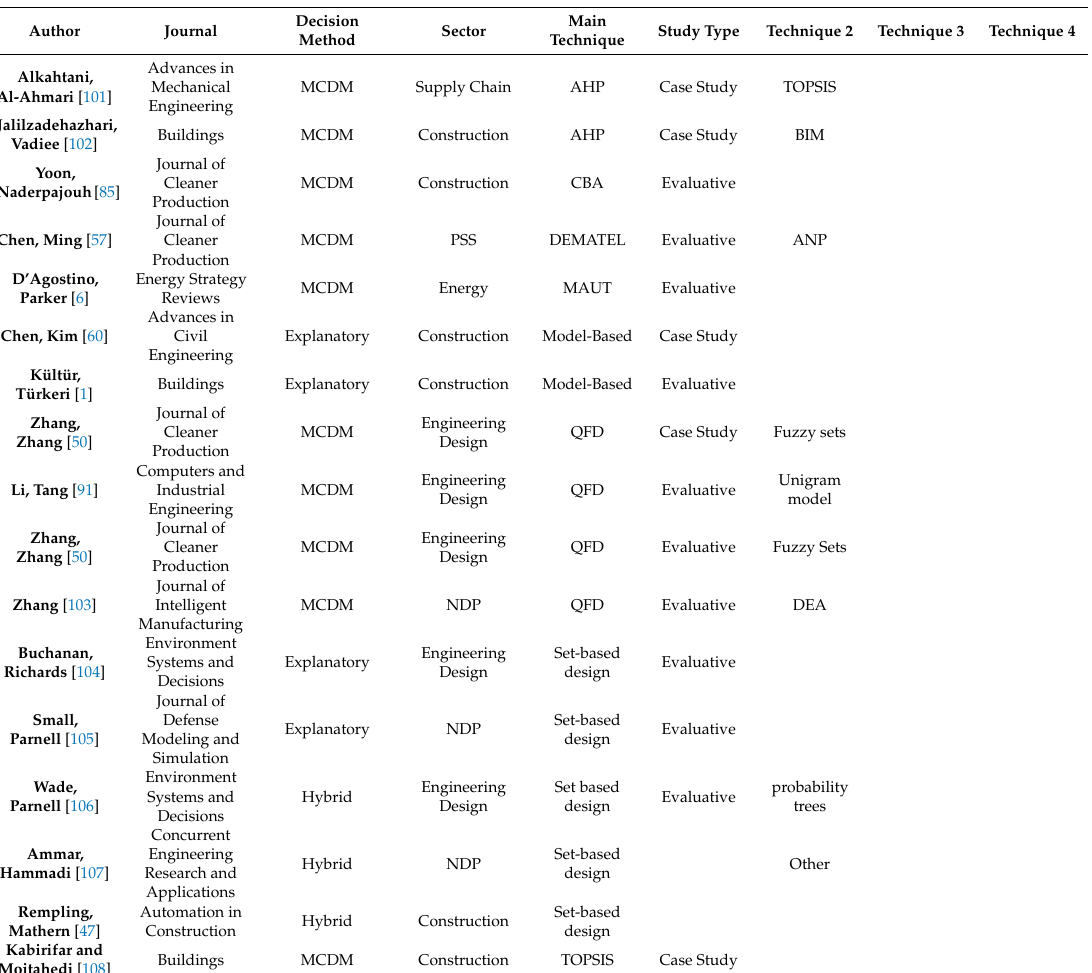
Table A1. Full results of the review